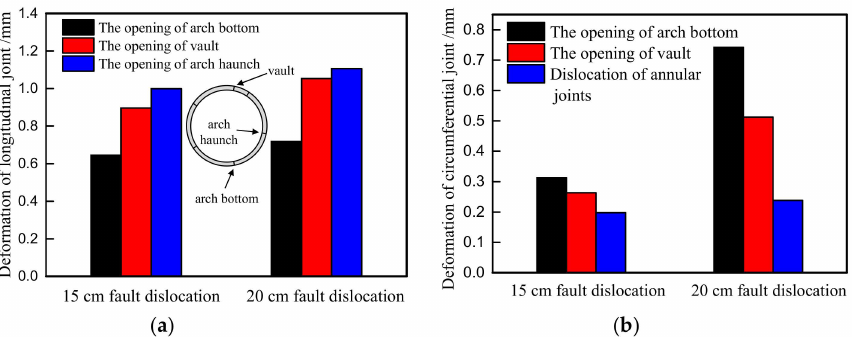
Figure 15. Deformation of segment joints subjected to reverse faulting. ( a ) Deformation of longitudi- nal joints and ( b ) deformation of -circumferential joints.